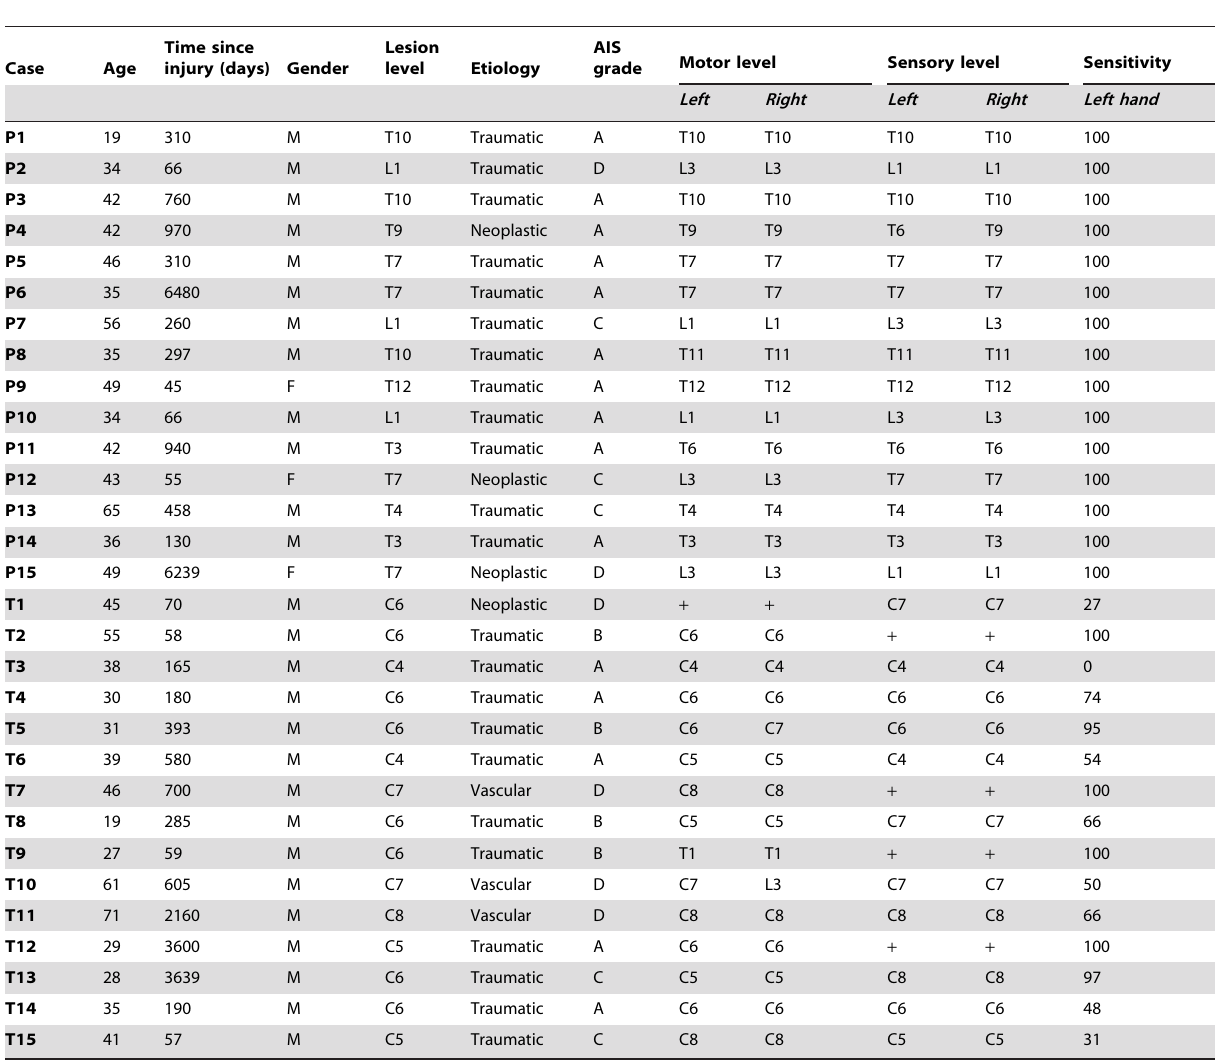
Table 1. Demographic and clinical data of the individuals with spinal cord